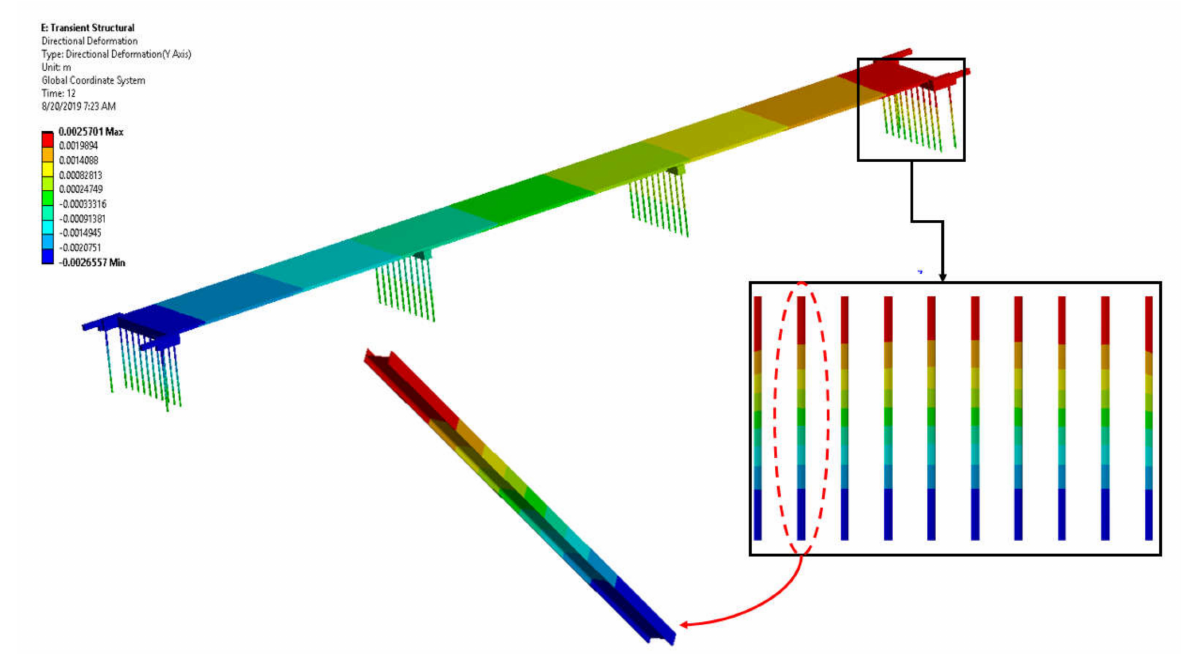
Figure 10. Longitudinal deformation of the deck due to the temperature variations during one year.